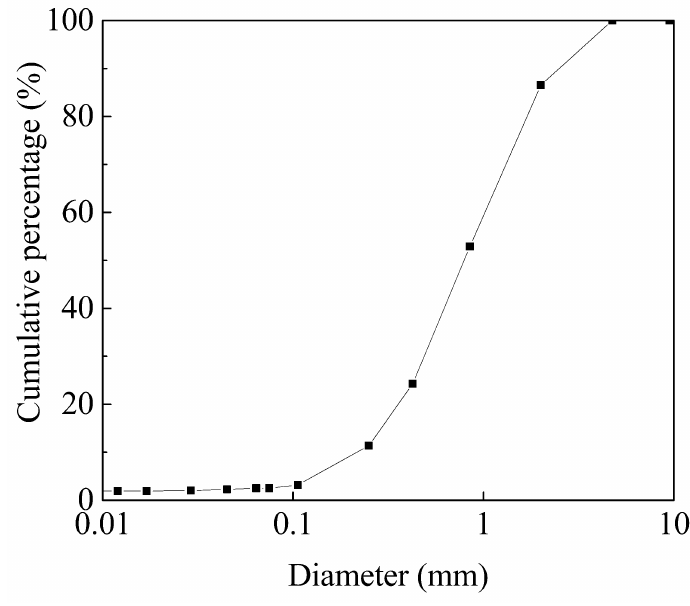
Figure 1. Particle-size distribution of sand.